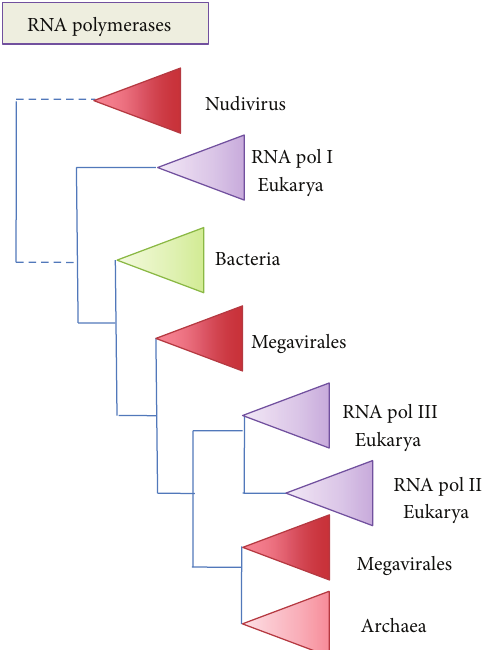
Figure 5: Schematic phylogenies of RNA polymerases.The RNA polymerase tree has been drawn combining and interpreting results from several papers [54, 60, 78, 79]. The position of the Nudivirus RNA polymerase is extrapolated from its high divergence with other homologous RNA polymerases (indicated by dotted lines).An update phylogeny would be welcome but would not change the take- home message, the puzzling mixture of cellular and viral enzymes, suggesting several ancient transfers between viruses and